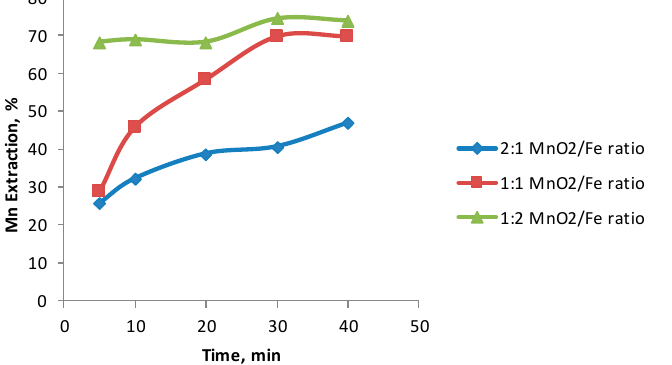
Figure 10. Effect of the MnO 2 /Fe ratio on manganese extraction (25 °C, − 200 + 270 Tyler mesh ( − 75 + 53 µ m), H 2 SO 4 1 M).